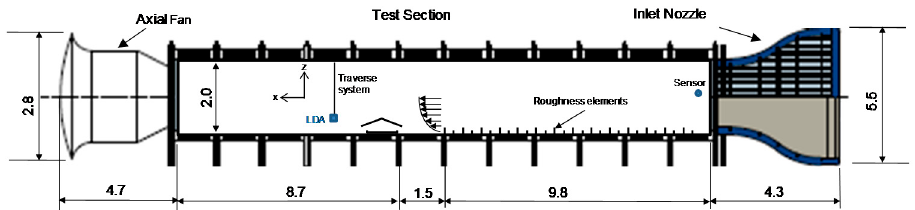
Figure 2. Schematic diagram of Boundary Layer Wind Tunnel (BLWT) (ATB, unpublished) and the experimental setup. All dimensions are in m.